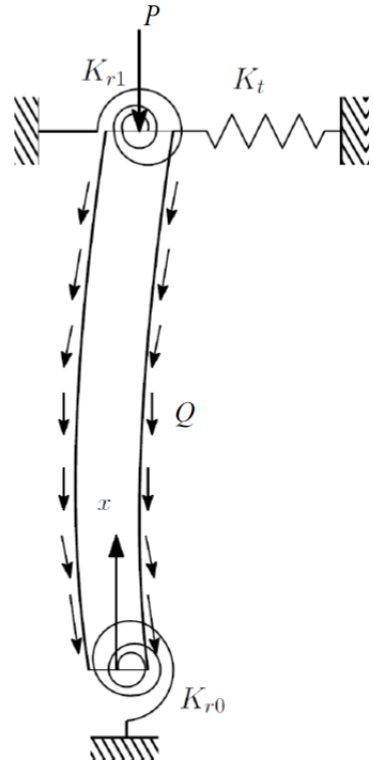
Figure 1. Elastically restraint columns under concentrated and dis- tributed axial